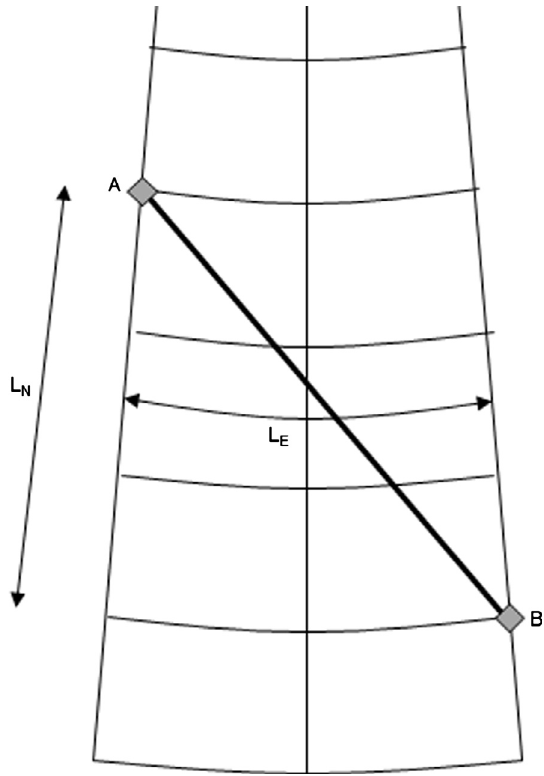
Fig. 6. Transmission line between substations A and B superim- posed on lines of latitude and longitude. The North-South and East- West distances between the substations are L N and L E respectively (from Horton et al. 2012).